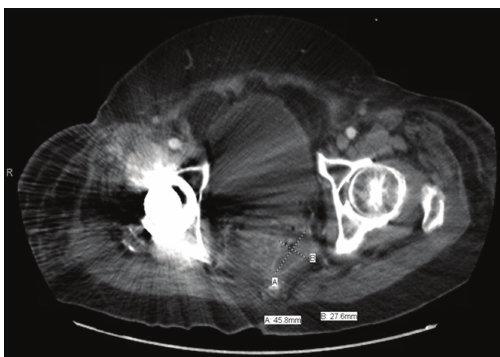
Figure 1: CT scan of the pelvis showing a perirectal fluid collection containing air locules. Fistulous tract to the anorectum not seen in this